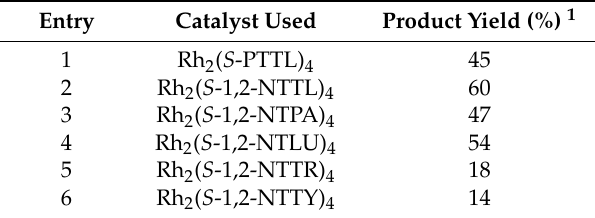
Table 1. Yields for the obtained cyclopropane